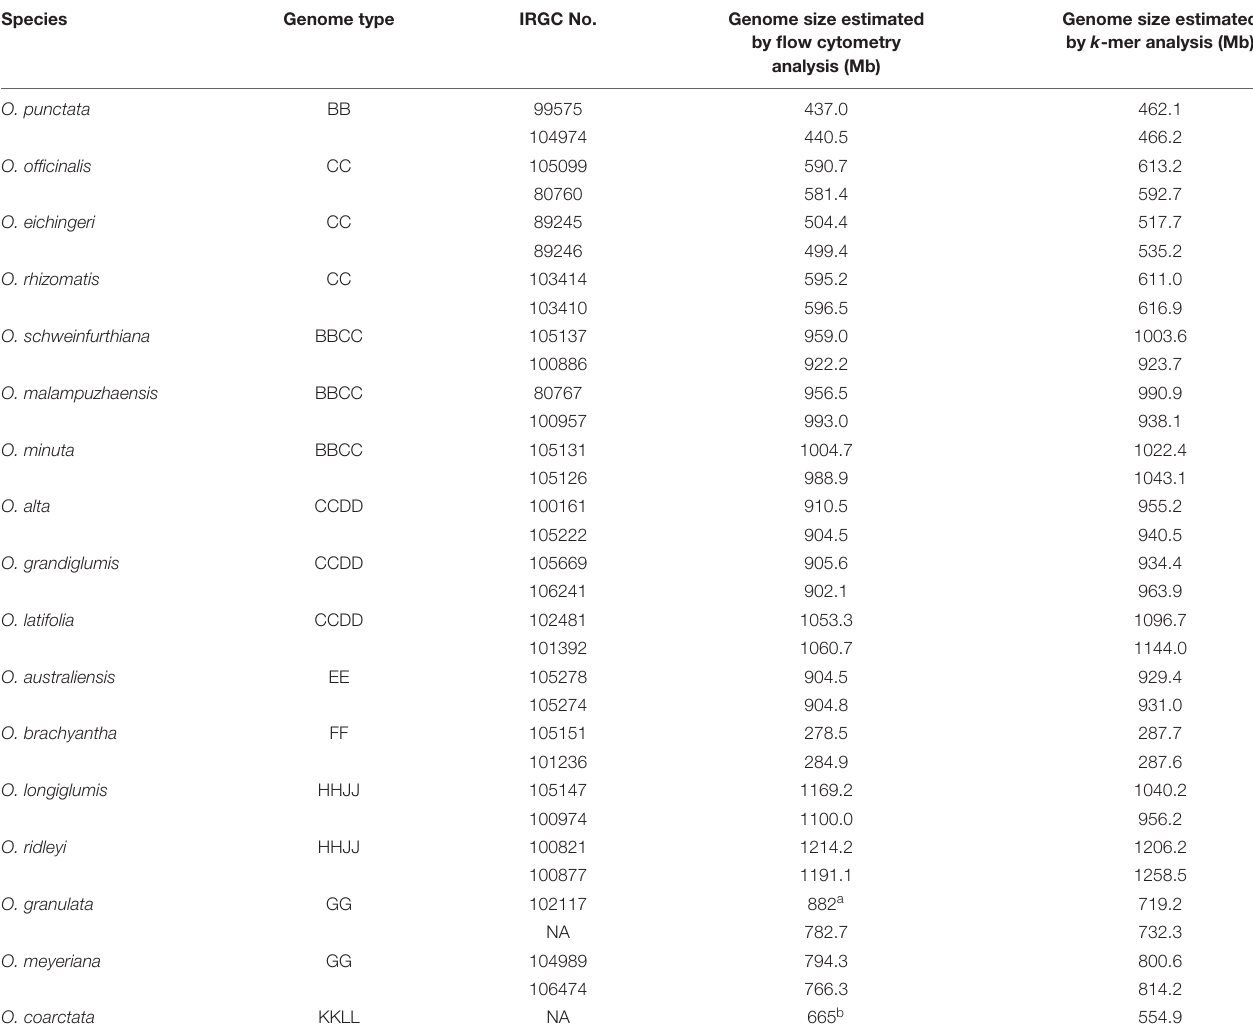
TABLE 2 | Genome sizes of Oryza species estimated by using flow cytometry and k -mer analyses.